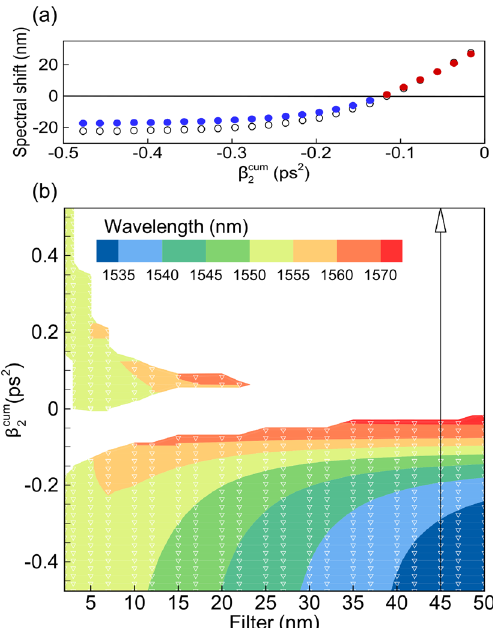
Figure 8. ( a ) Shift of the wavelength of the generated pulse from the central wavelength of the optical filter for varying cumulative dispersion (here filter bandwidth is 45 nm). Empty circles correspond to the laser with the infinite gain bandwidth. ( b ) Output pulse wavelength as a function of the filter bandwidth and cumulative cavity